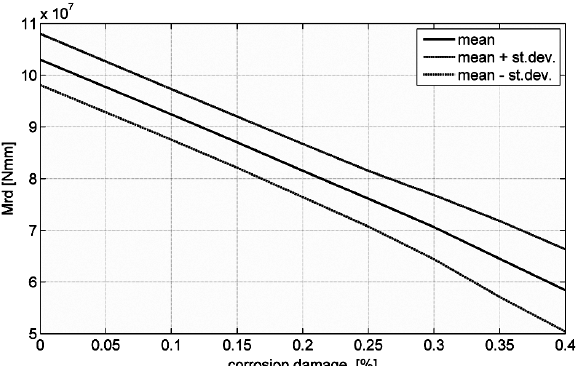
Fig. 8. The time dependant ultimate flexural strength of the beam as a function of the corrosion damage